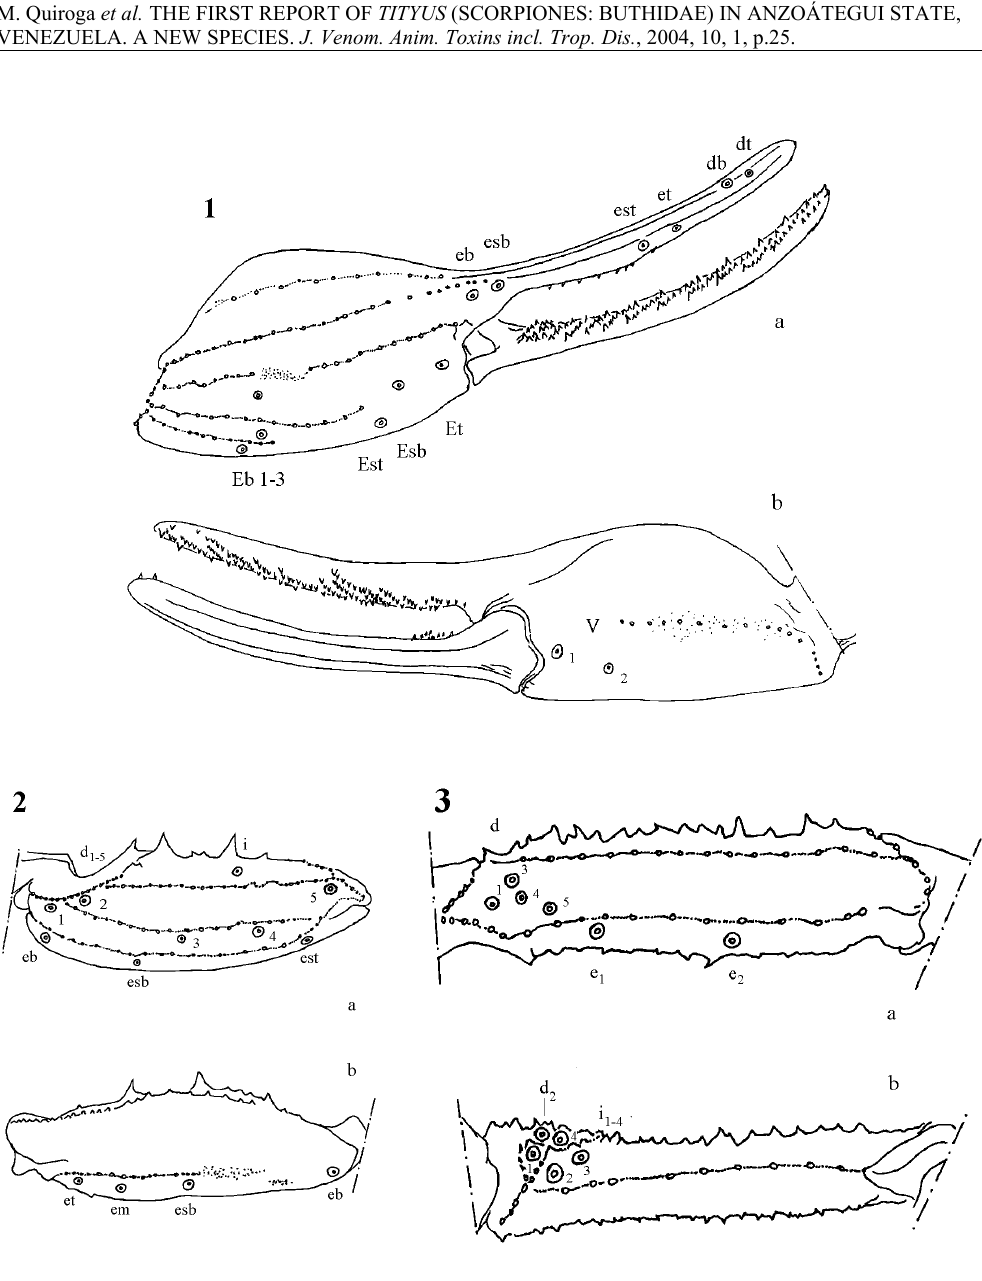
Figure 3 . Tityus gonzalespongai n. sp . Male. 1. Right chela. a. Dorsal view. b. Ventral view. 2. Right tibia. a. Dorsal view. b. Ventral view. 3. Right femur. a. Dorsal view. b. Internal